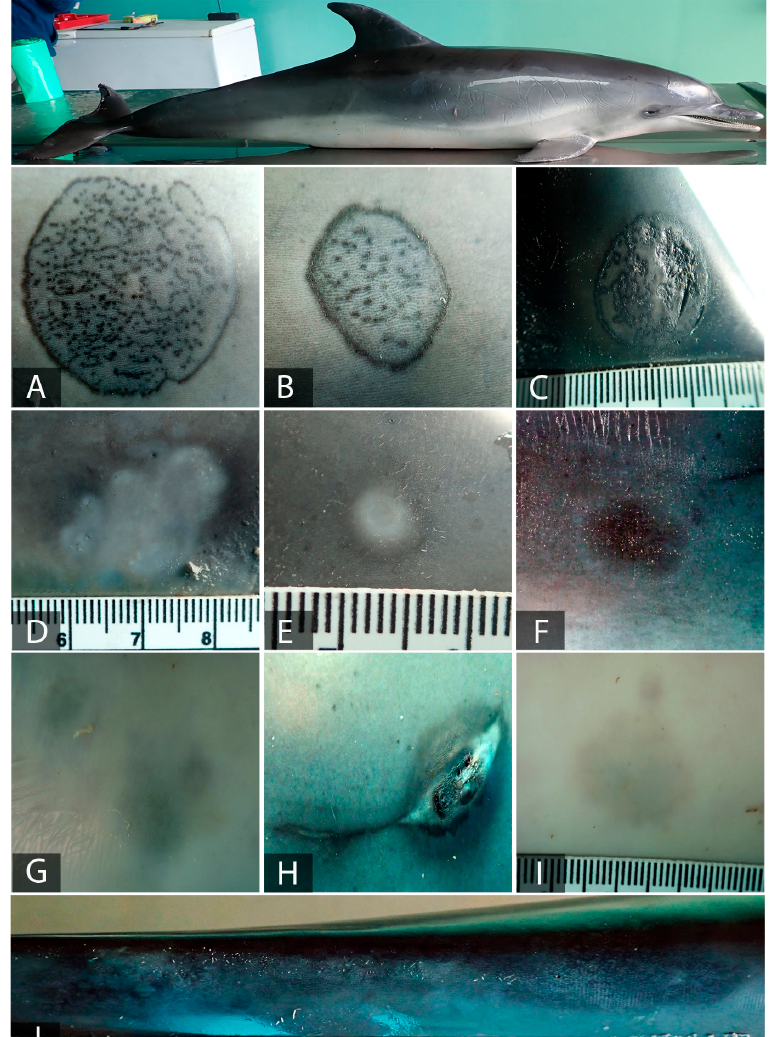
Figure 3. Gross lesions compatible with CePV in Atlantic spotted dolphin, Case 2. Right lateral view. ( A ) Ring lesion with a black edge and stippled pattern center (3 × 2.3 cm) on the right side of the melon. ( B ) Ring lesion with a black edge and stippled pattern center (1 × 0.7 cm) located on the right side of the melon. ( C ) Oval lesion presenting both margin and inner ping-hole pattern slightly raised with half of the center blistered (1.8 × 1.3 cm), located on the right side of the dorsal fin. ( D ) Irregular pale and coalesced wound with a barely visible dark edge (2.3 × 1.2 cm) located on the right dorsolateral superior hemimaxilla. ( E ) An oval lesion with a pale center and blurred margin (0.6 × 0.3 cm) situated on the right dorsal part of the tip. ( F ) Oval dark lesion with pale margin (1.5 × 1 cm) located on the right side of the animal. ( G ) A blurred and irregular grey lesion on the rostroventral part. ( H ) An oval dark lesion with a pale, raised, and irregular center (1.6 × 1.3 cm) on the right lateral side. ( I ) A blurred hardly visible grey lesion (1.8 × 1.5 cm) on the ventral part of the animal. ( J ) A large and irregular dark lesion with a greyish pin-hole pattern across the entire center located on the dorsal part of the peduncle.